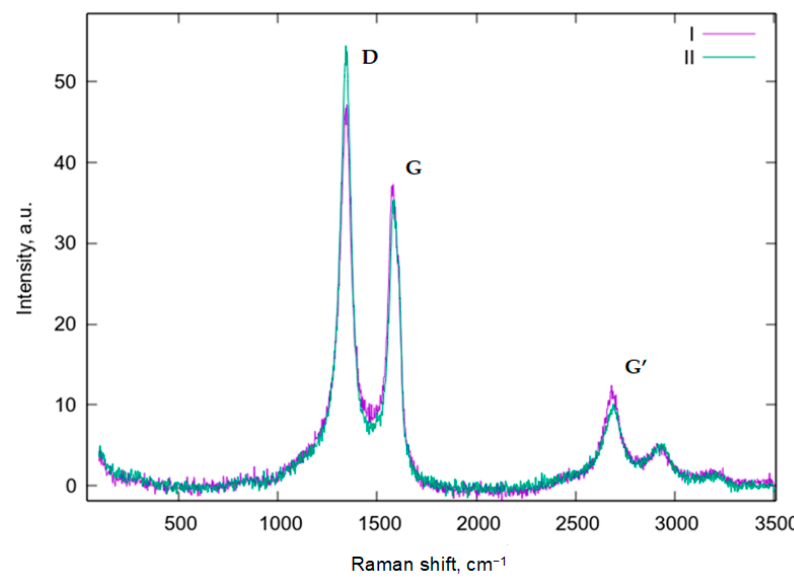
Figure 3. Raman spectra of initial (I) and microwave-treated (II) MWCNTs.